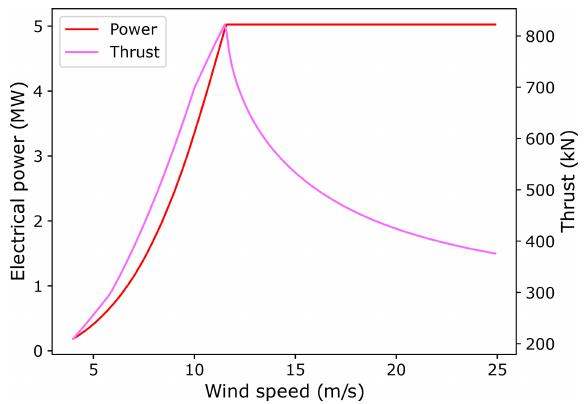
Figure 1. Power and thrust operational strategy curves for the NREL 5MW wind turbine model used in this